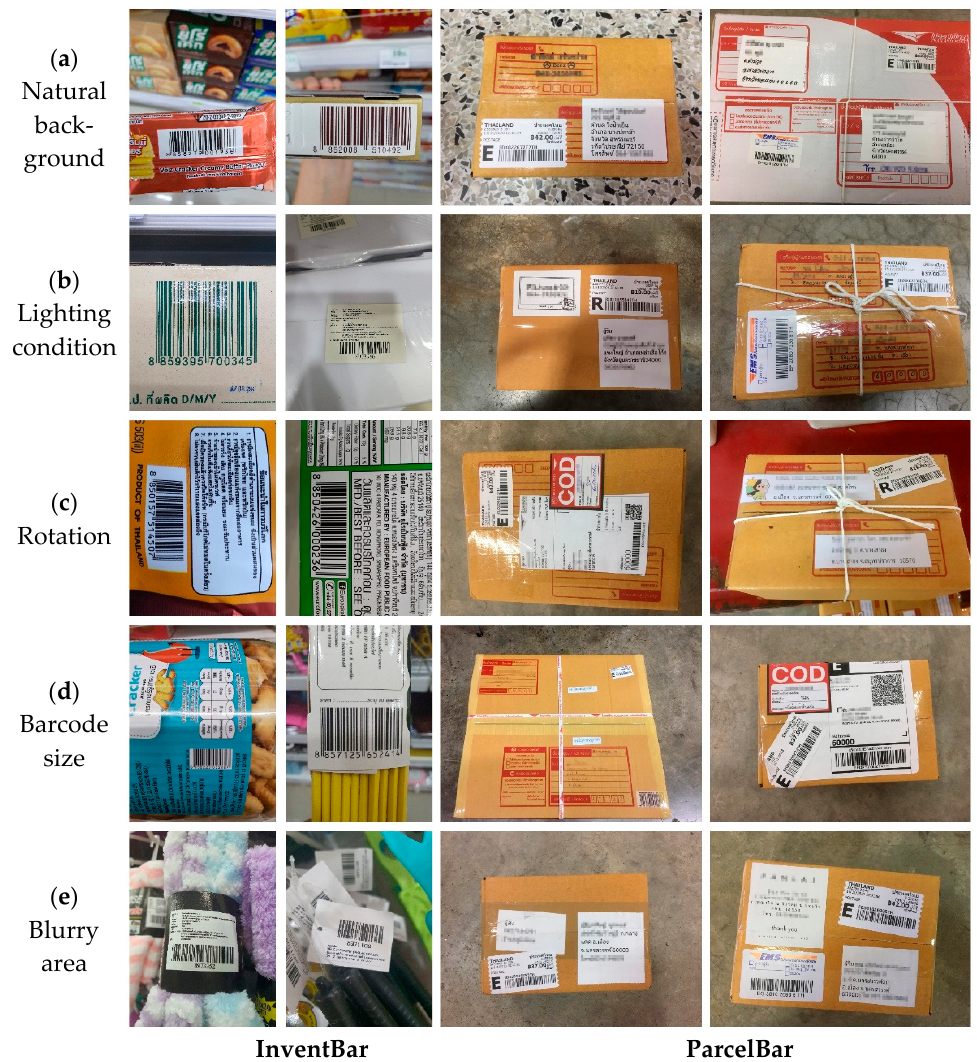
Figure 1. Example barcode images from the InventBar and ParcelBar datasets with distinctive natural characteristics: ( a ) natural background, ( b ) lighting conditions, ( c ) rotation, ( d ) barcode size, and ( e ) blurry